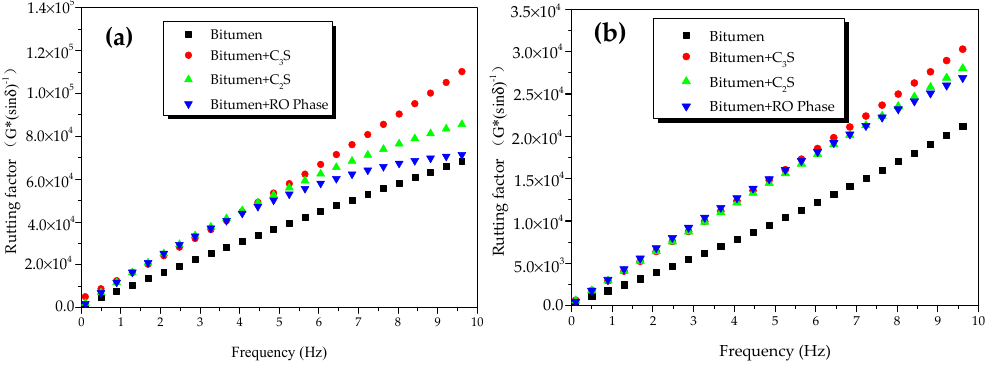
Figure 12. Rutting factors of bitumen–mineral mixtures at different temperatures: ( a ) 45 °C and ( b ) 55 °C.